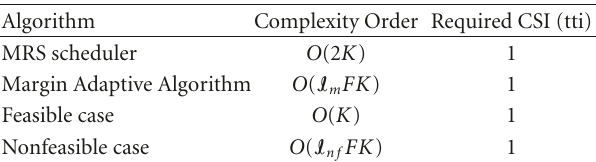
Table 3: Complexity order of di ff erent algorithms for K users and F subcarriers in the